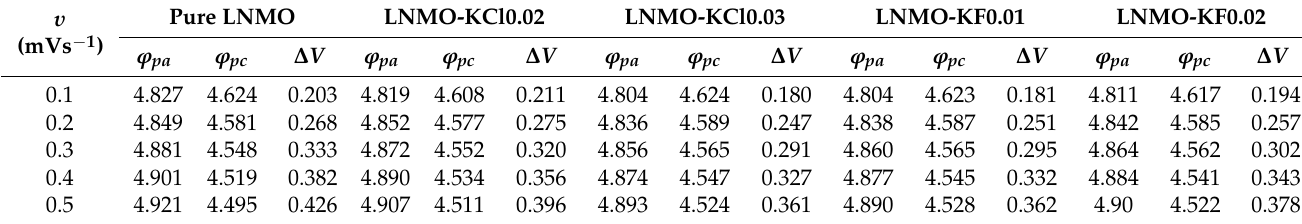
Table 2. Potential differences ( ∆ V , V) between anodic ( ϕ pa , V) and cathodic ( ϕ pc , V) peaks.